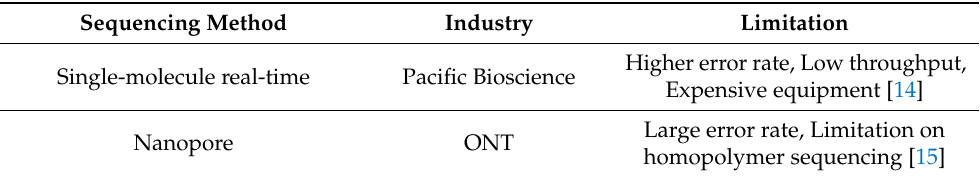
Table 2. Limitations of long-read sequencing